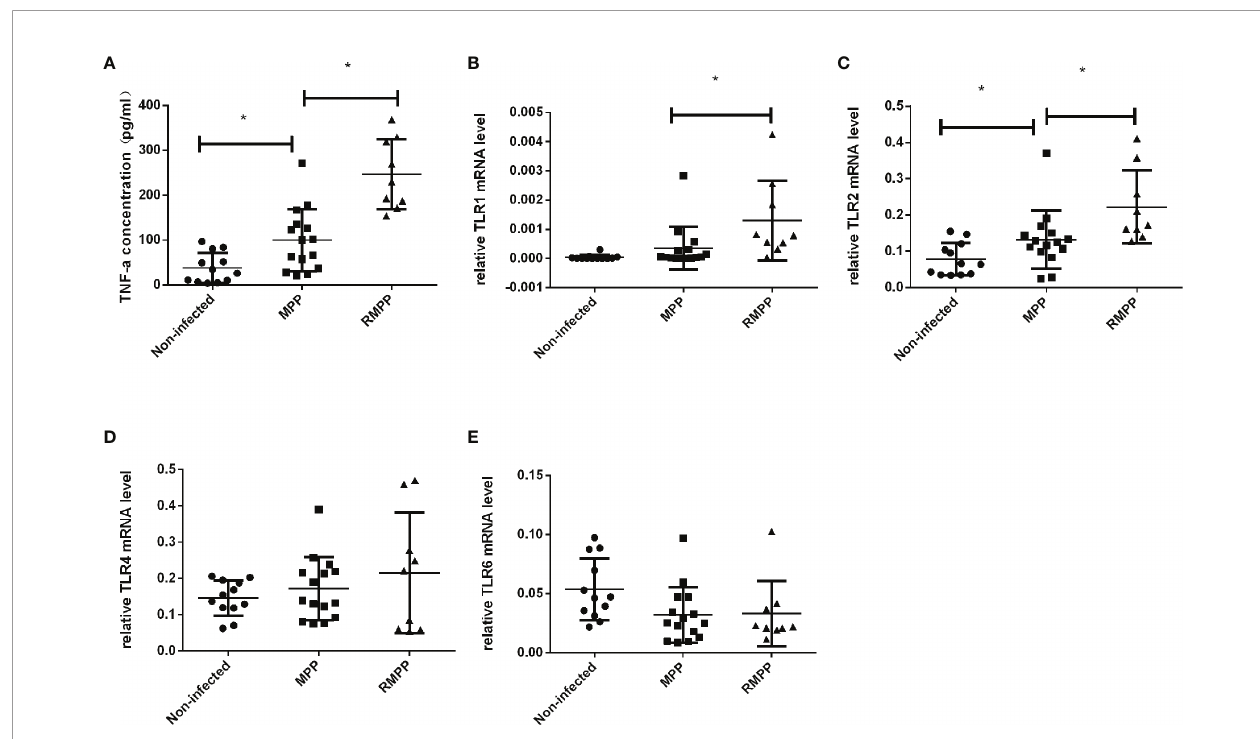
FIGURE 1 | Serum TNF- a levels in the three study groups. (A) The levels of serum TNF- a was determined by ELISA. (B – E) TLR1, TLR2, TLR4, and TLR6 mRNA relative expression level in children ’ s blood neutrophils were determined by RT-qPCR and were normalized by human GAPDH gene. * P < 0.05 is statistically signi fi cant. MPP, Mycoplasma pneumoniae pneumonia; RMPP, refractory M. pneumoniae